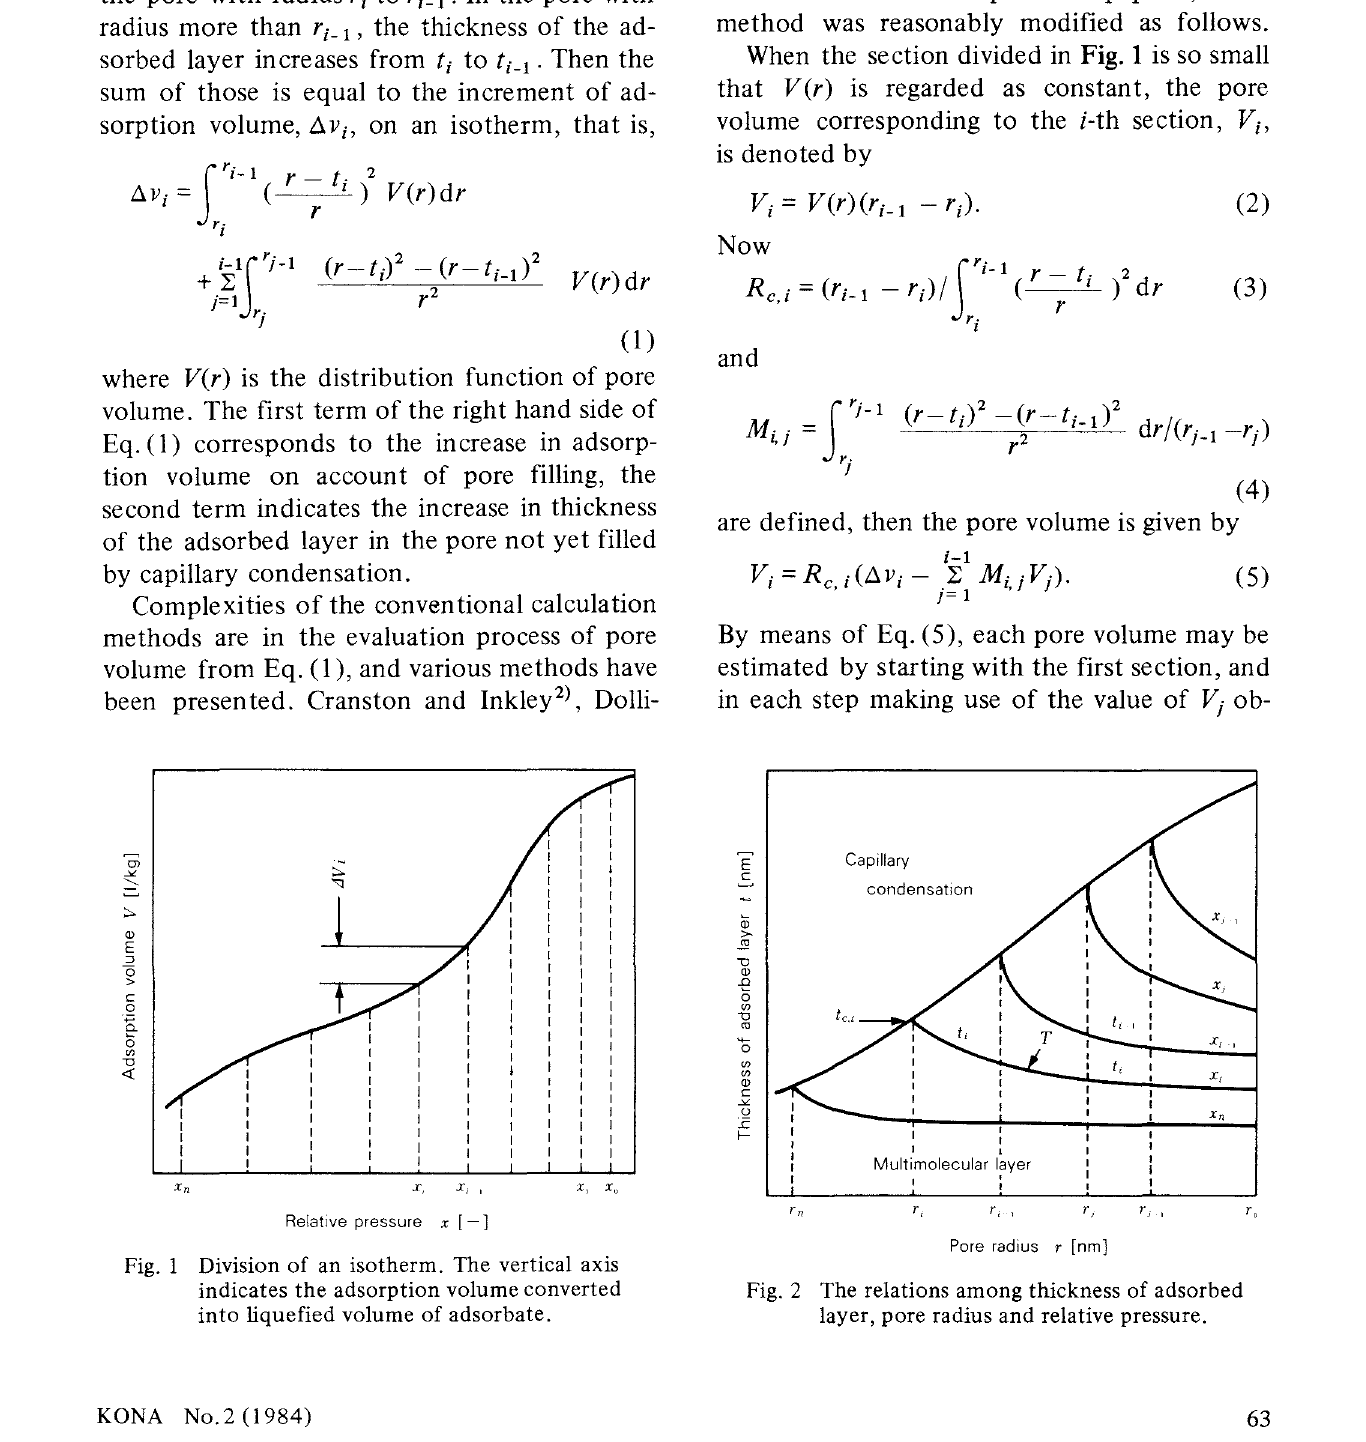
Fig. 2 The relations among thickness of adsorbed layer, pore radius and relative